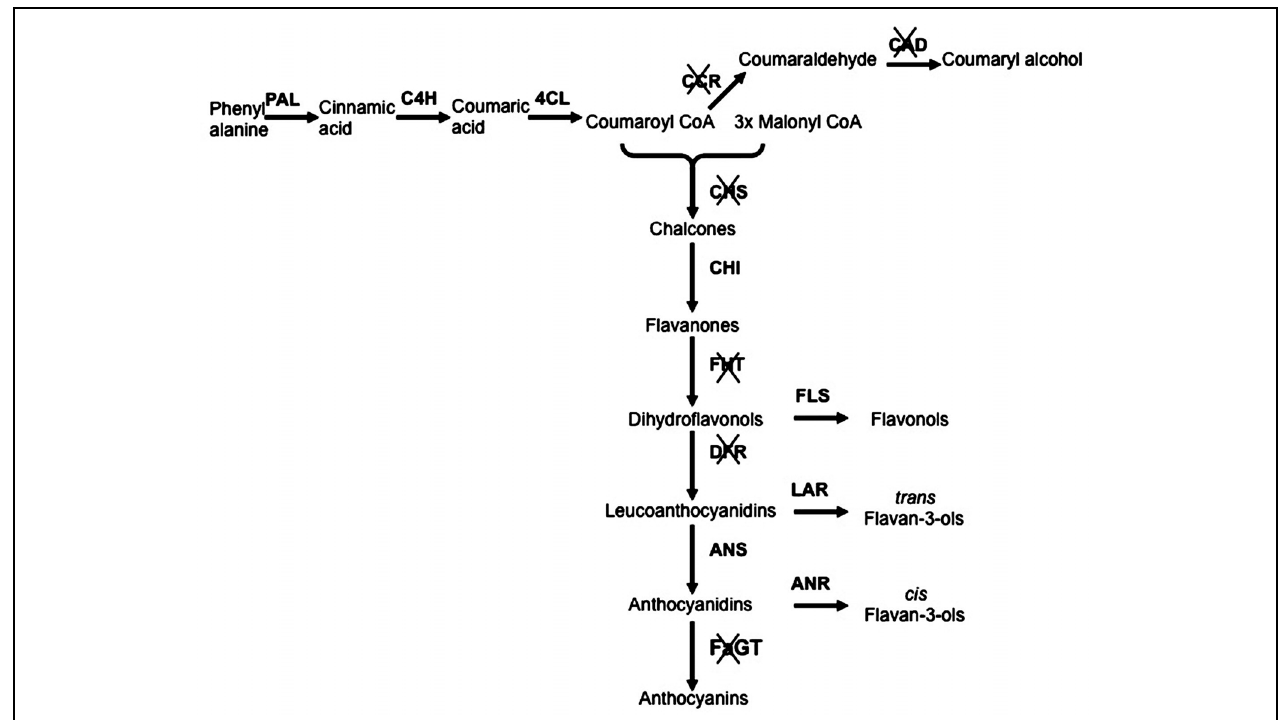
FIGURE 1 | Schematic representation of phenylpropanoid/flavonoid pathway with silenced genes. The genes functionally investigated throughout RNA interference (RNAi)-transient transformation are crossed. Genes abbreviations: PAL, phenylalanine ammonia lyase; C4H, cinnamic acid 4-hydroxylase; 4CL, p-coumarate:CoA ligase; CCR, Cinnamoyl-CoA reductase;